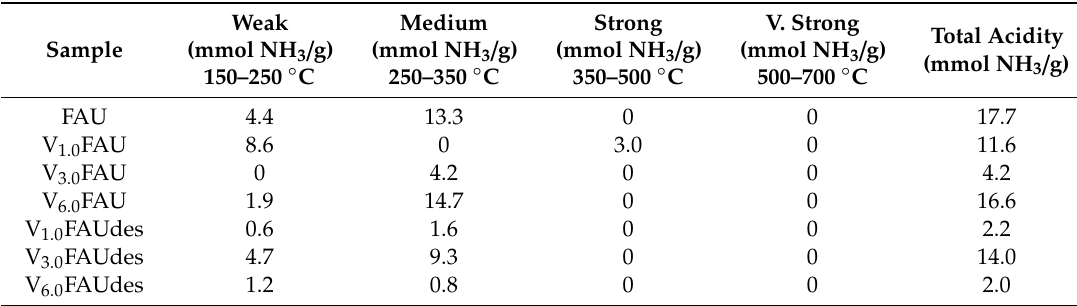
Table 4. Distribution of acid sites and total acidity as of the temperature-programmed desorption of ammonia (NH 3 -TPD) experiments.